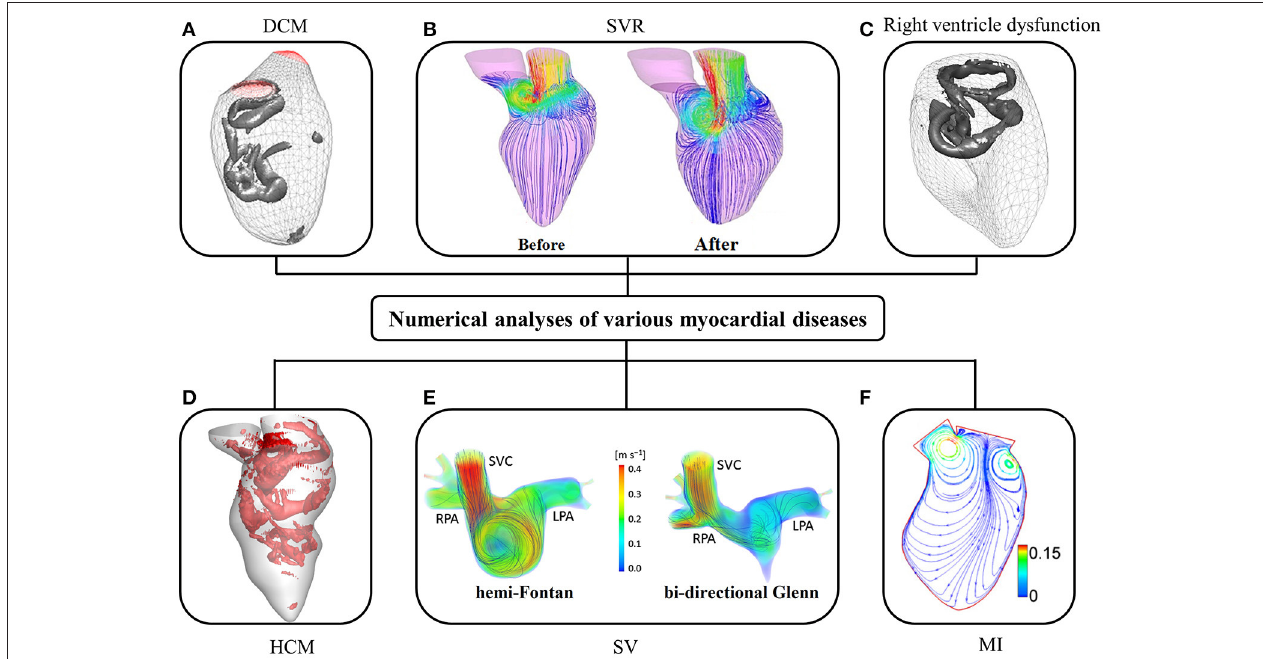
FIGURE 6 | CFD simulation of intra-cardiac flow showing (A) vortex formation in dilated cardiomyopathy (DCM) (Mangual et al., 2013); (B) the distribution of blood velocity before and after surgical ventricular restoration (SVR) ( Khalafvand et al., 2014); (C) vortex formation in right ventricle (Mangual et al., 2012); (D) vortex formation in hypertrophic cardiomyopathy (HCM); (E) distribution of blood velocity in a single ventricle (SV) (SVC, superior vena cava; RPA, right pulmonary artery; LPA, left pulmonary artery); (F) the distribution of blood velocity in the LV with myocardial infarction (MI) ( Khalafvand et al.,